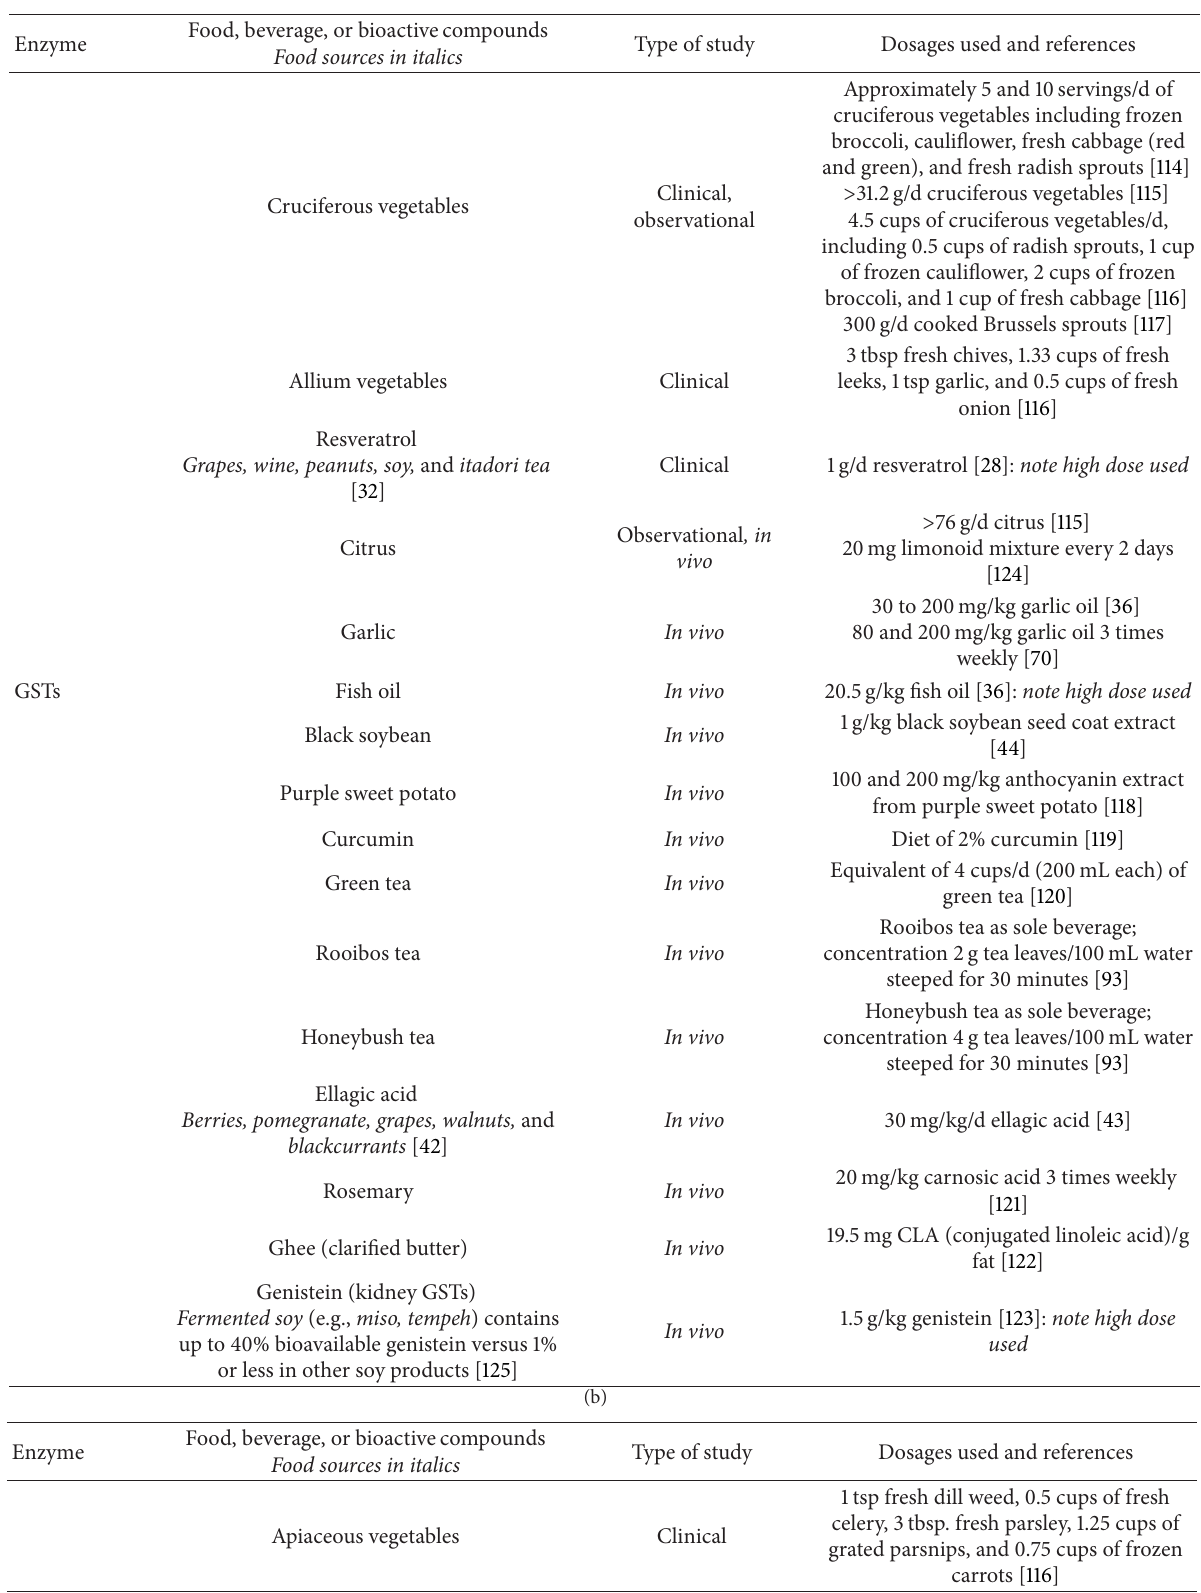
Table 7: (a) In vivo example nutrient inducers of glutathione S-transferases (GSTs). (b) In vivo example nutrient inhibitors of glutathione S-transferases (GSTs). (c) Selected dietary sources of nutrients for glutathione support ([111] unless otherwise